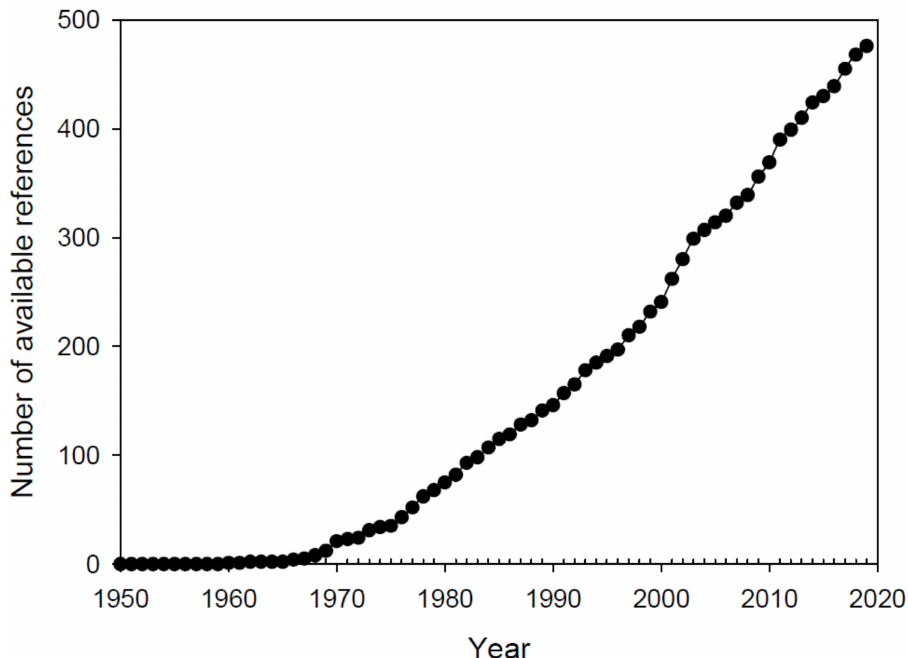
Figure 2. Cumulative number of available references related to radiative parameters (oscillator strengths and transition probabilities) for neutral, singly-, doubly- and triply-ionized lanthanides taken from the NIST bibliographic database